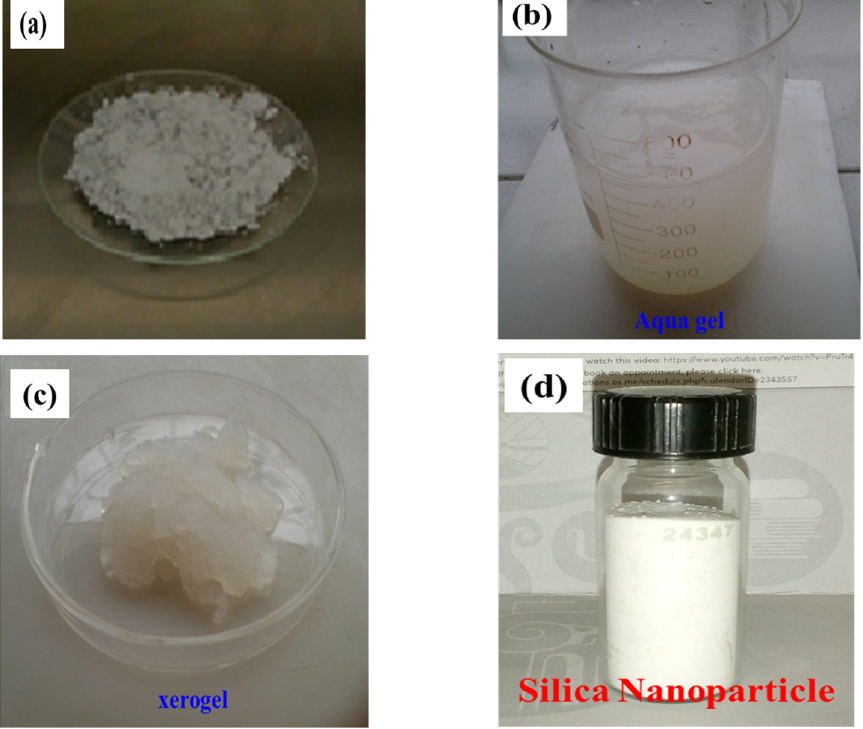
Figure 1. ( a ) SAFA, ( b ) silica aquagel, ( c ) silica xerogel, ( d ) silica nanoparticles. Table 1. XRF analysis of SAFA and SNP. Table 1. XRF analysis of SAFA and SNP. Composition